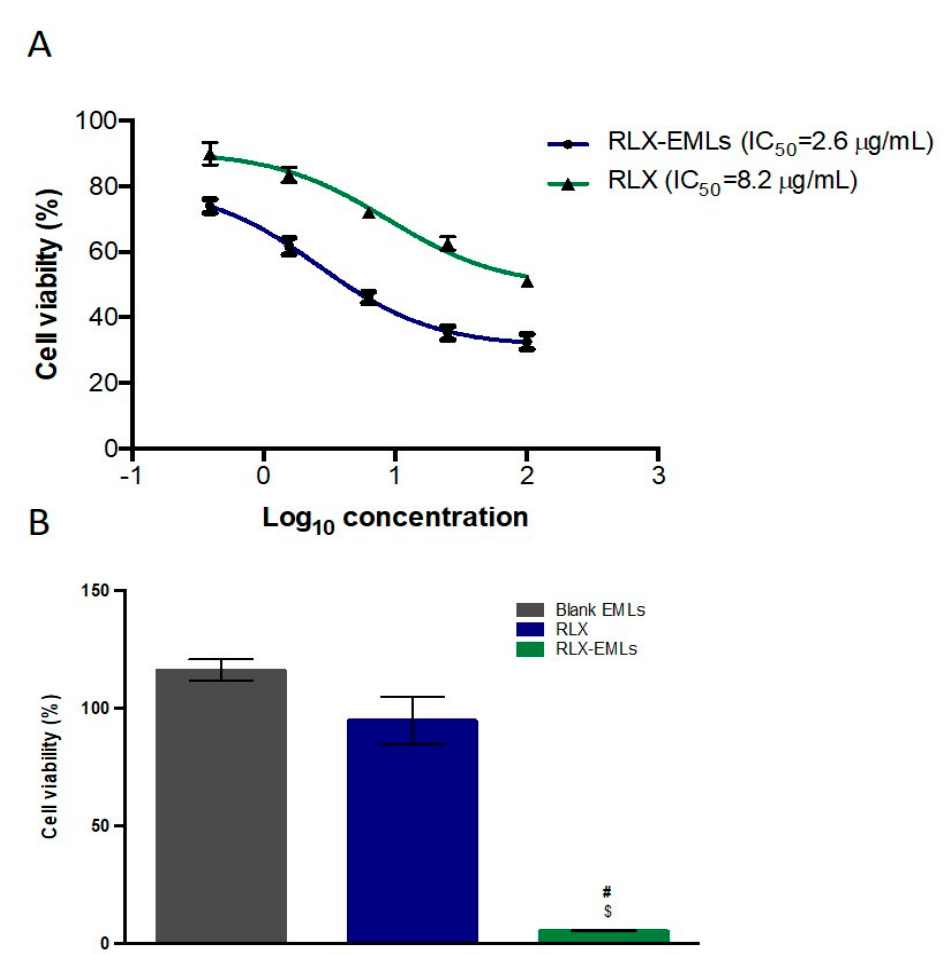
Figure 2. Effect of RLX-EMLs or RLX on MCF-7 cell viability using MTT assay. The cells were treated with RLX-EMLs or RLX for 48 h. ( A ) dose-response curve with IC 50 values; ( B ) comparison of cell viability results using 0.1 µM of RLX. $ P < 0.0001 considered significantly different from RLX, # P < 0.0001 considered significantly different from blank EMLs.